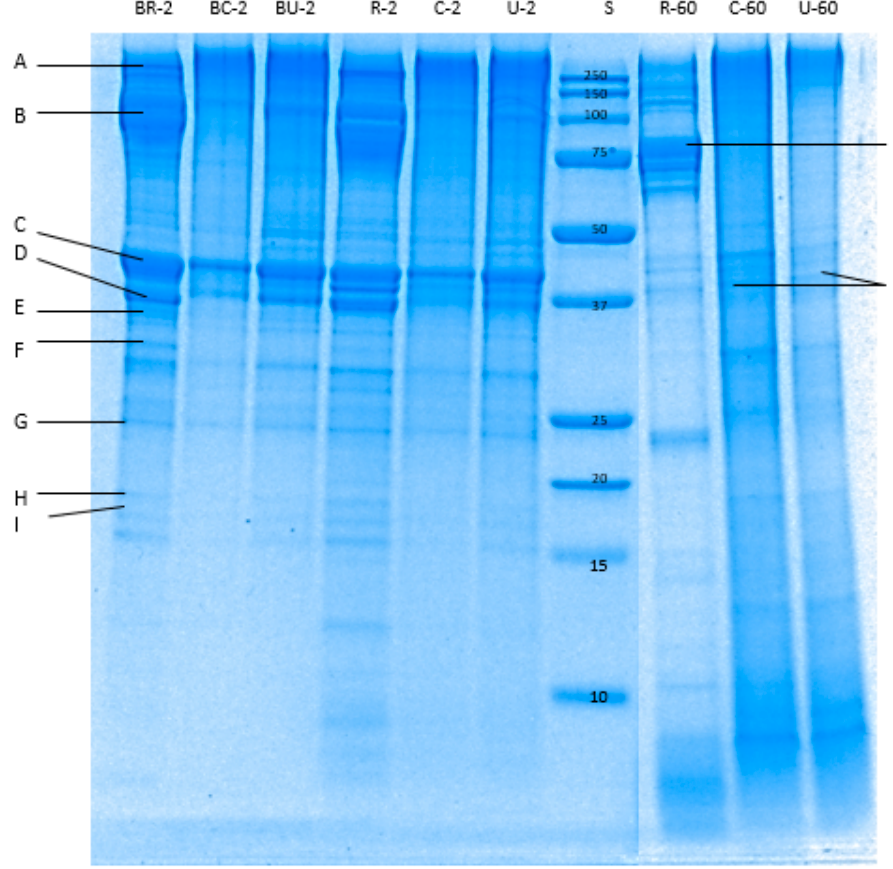
Figure 8. Tricine sodium dodecyl sulphate-polyacrylamide gel electrophoresis (SDS-PAGE) electrophoretogram showing protein profile of the digested p ā ua samples after 2 or 60 min of gastric